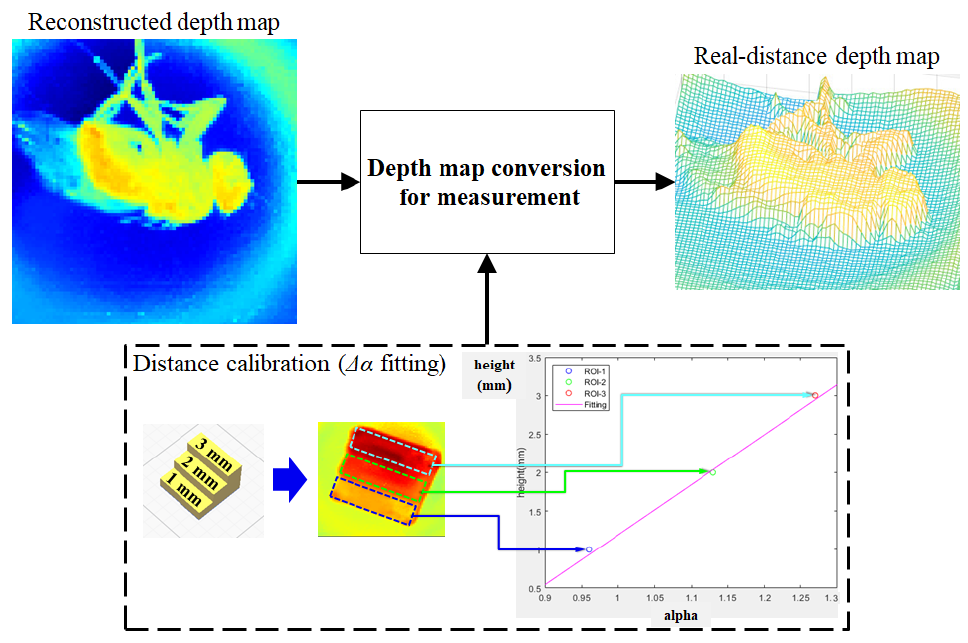
Figure 5. Depth map conversion process via distance calibration.